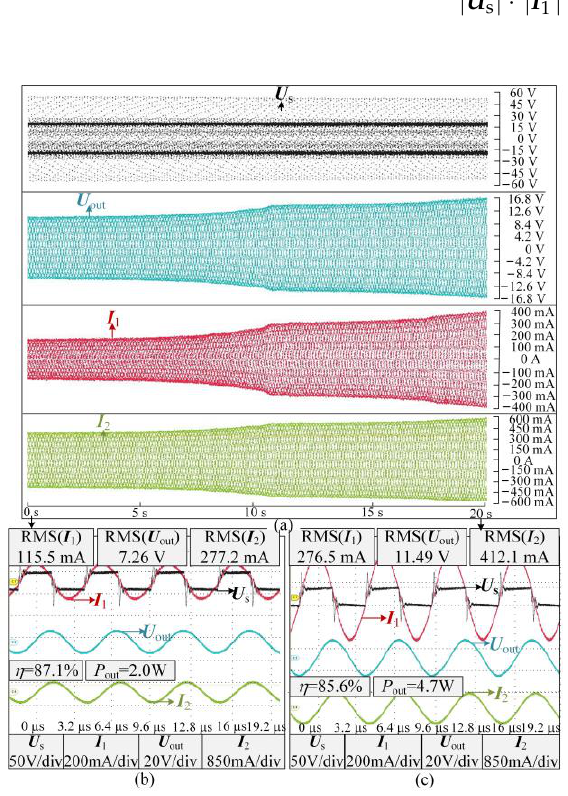
Figure 10. Experimental waveforms of U s , I 1 , I 2 and U out before compensation. Continuous wave- form: ( a ) 0.1-m offset in the Y -axis occurs first and then 0.1-m offset in the X -axis occurs. Stationary waveform: ( b ) well aligned; ( c ) 0.1-m offset in the X -axis and Y -axis occurs simultaneously.